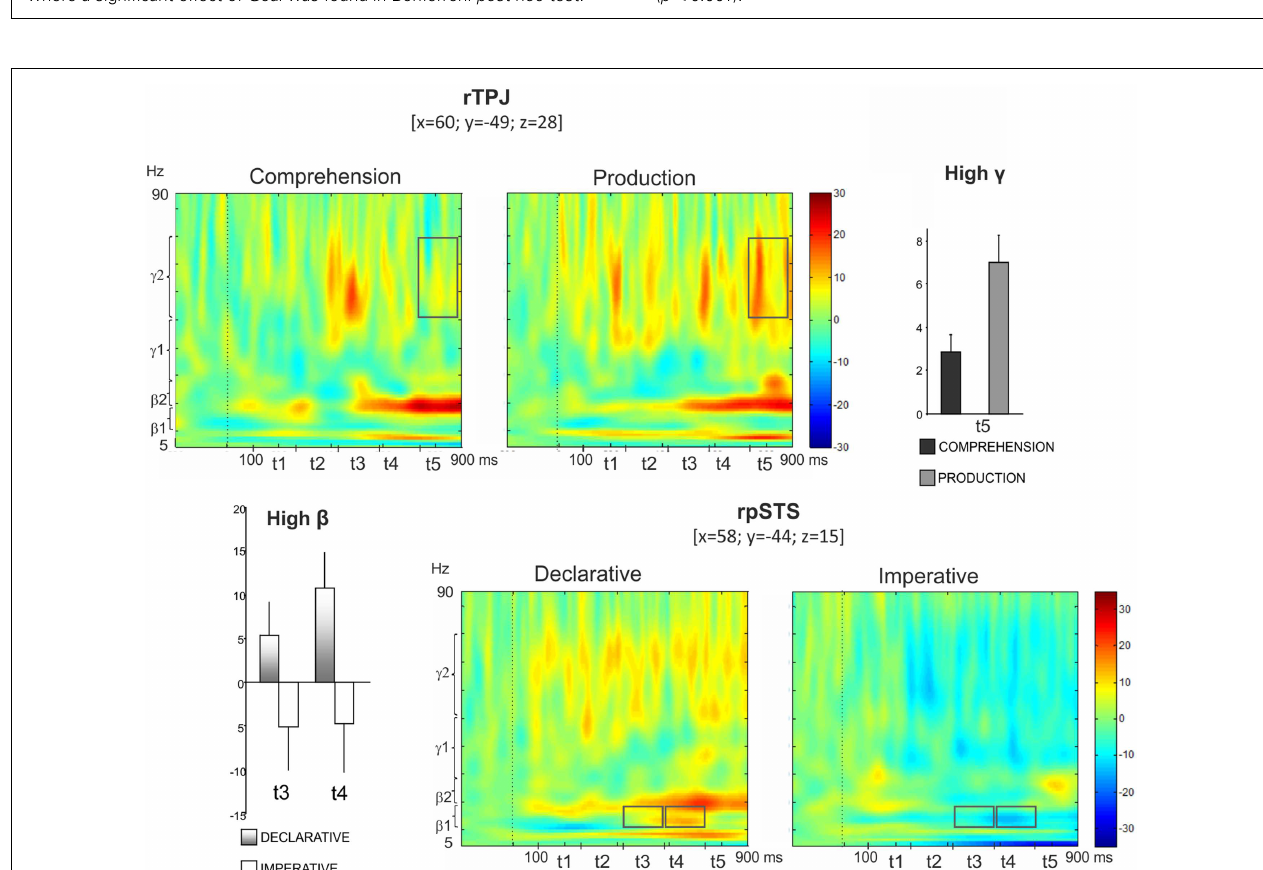
FIGURE 4 |Anterior cingulate cortex (ACC) . GroupTFRs during declarative and imperative sessions: dotted line indicates the stimulus onset (left). Gray boxes indicate the frequency bands and time intervals where a significant effect of Goal was found in Bonferroni post hoc test.